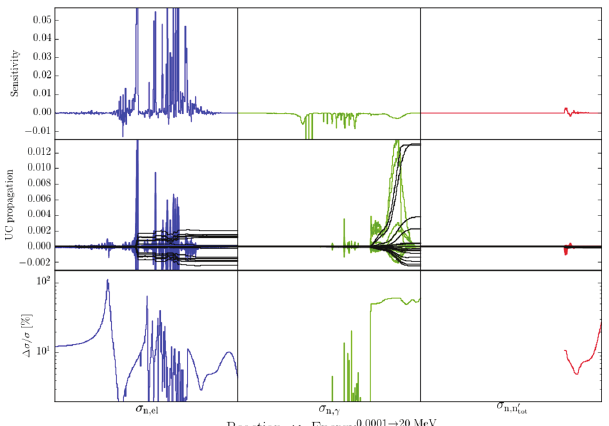
Fig. 9. Qualitative uncertainty propagation (without corre- lations): sensitivity (top), relative uncertainty (bottom), and product (middle) together with the cumulative propagated uncertainty curve in